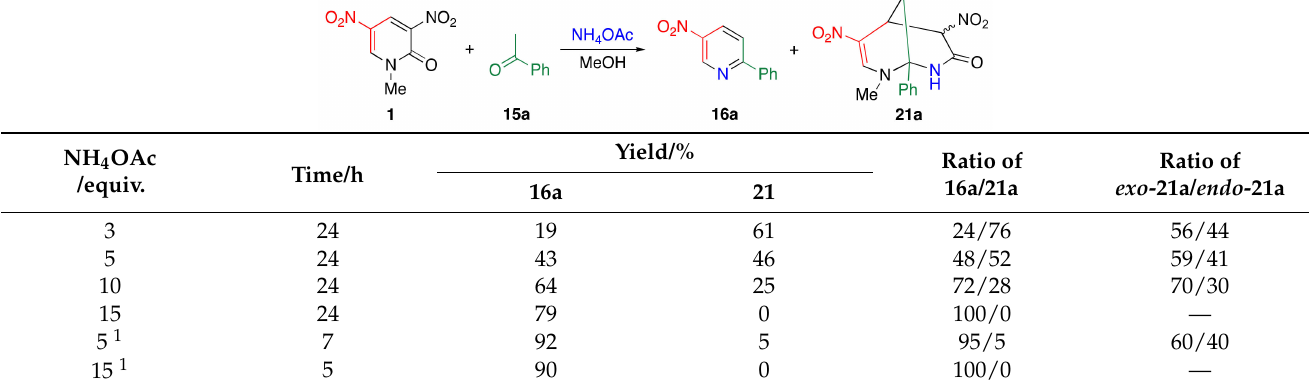
Table 3. TCRT using pyridone 1 with different amounts of ammonium